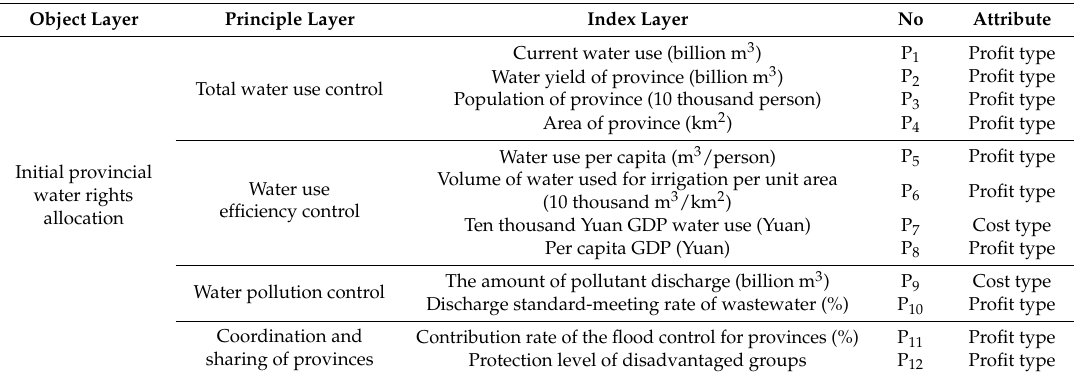
Table 1. The index system of initial provincial water rights